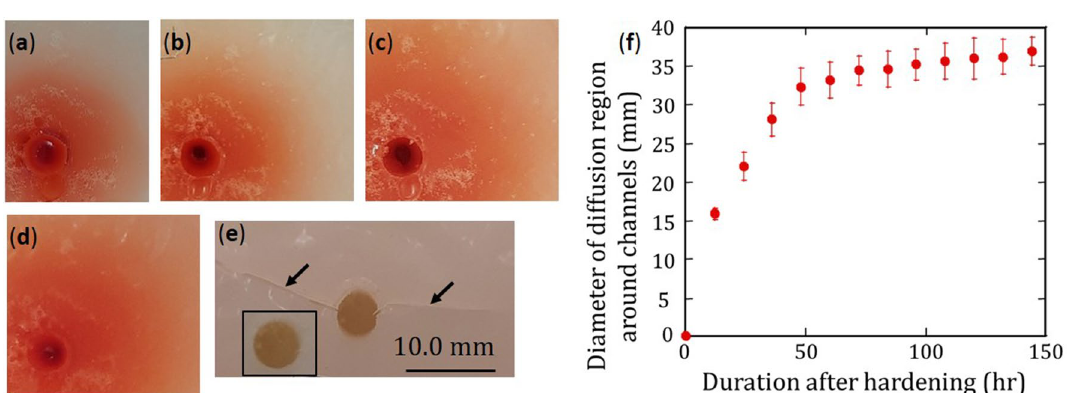
Figure 2. Region of agar around channels (at bottom left) showing diffusion of red die after nutrient solution has been introduced for ( a ) 12 h; ( b ) 24 h; ( c ) 48 h and ( d ) 72 h in the channels. ( e ) For agar with no solution in channels, cracks (arrows) propagate in agar from channel walls due to shrinkage after about 120 h; no cracks were observed at shorter time (inset). ( f ) Diameter of diffusion region around channels increases with time. (Image was created using MS-Powerpoint, Version 16.16.22 (200,509) (Microsoft PowerPoint for Mac), https :// www.micro soft.com and using Kaleidagraph, Version 3.51, https ://www.syner